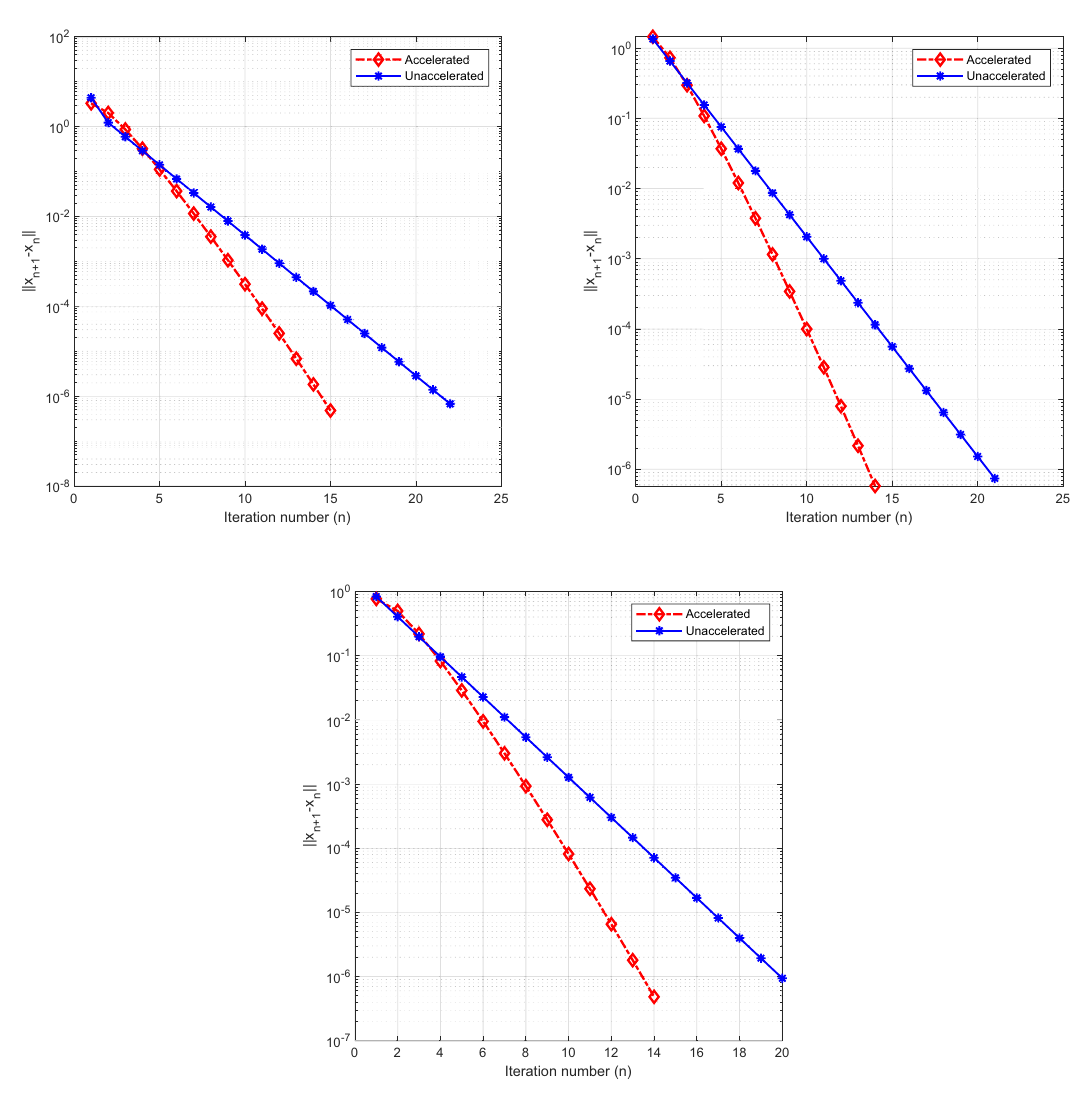
Figure 2: Example 4.2, top left: Case ( 1 ) ; top right: Case ( 2 ) and bottom: Case ( 3 )